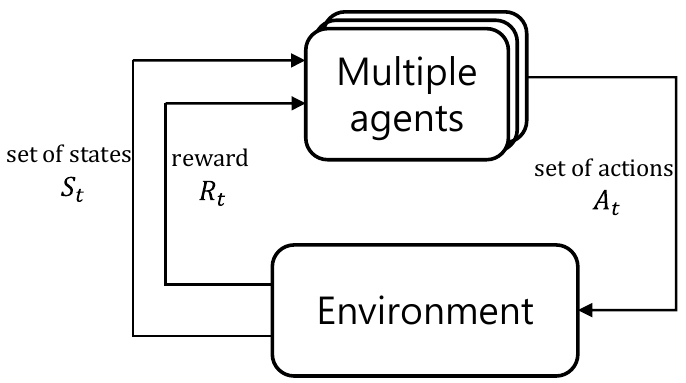
Figure 4. Framework of multiagent RL.